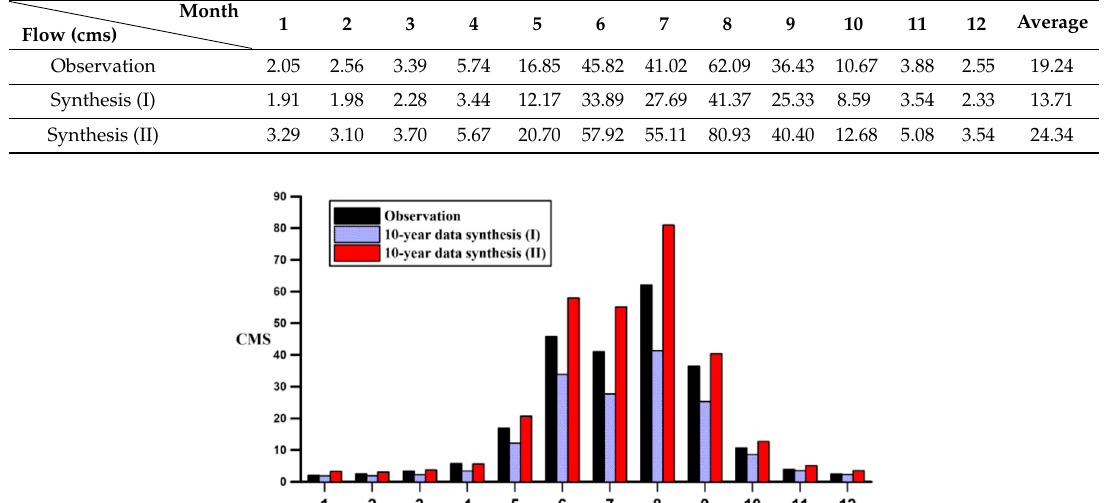
Figure 15. Comparisons of 10-year flow data with Method I. P(X > x): probability of exceedance.